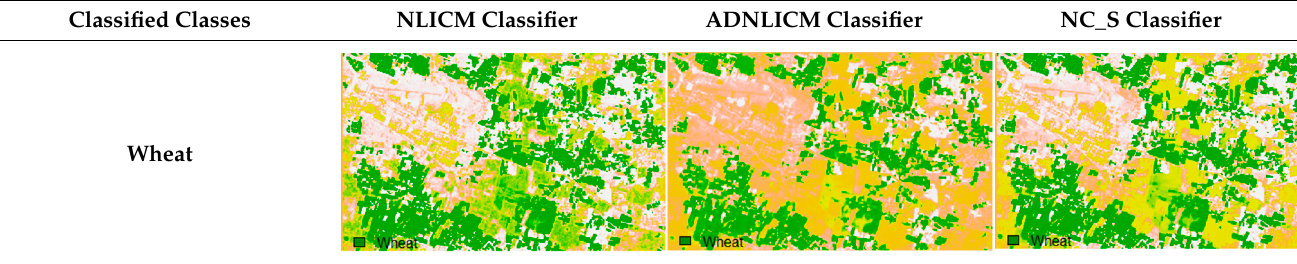
Table 15. Variance within the classes for the given algorithms for site 2 (Banasthali).